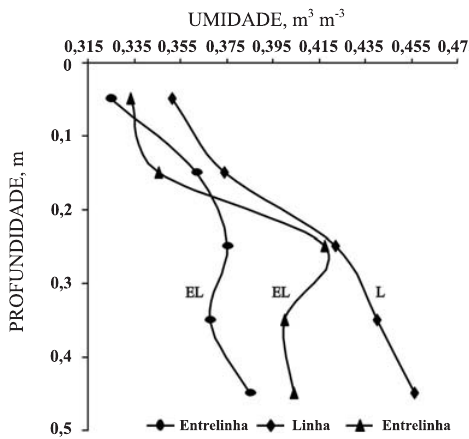
Figura 2. Comportamento da umidade no solo durante as investigações com o